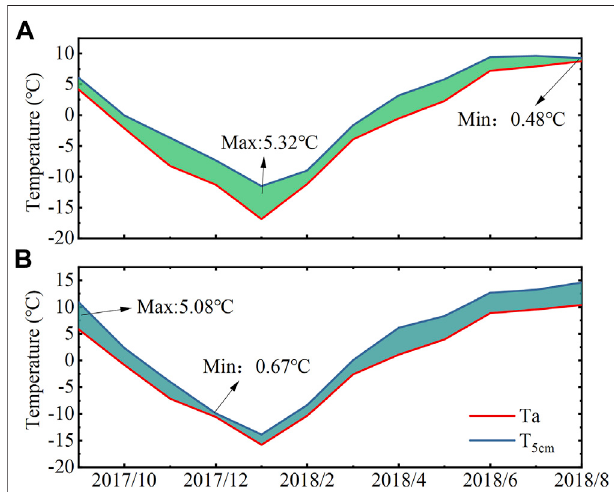
FIGURE 7 | Isoline map of soil unfrozen water content in two sites: (A) TS-04 site, (B) TS-05 site.